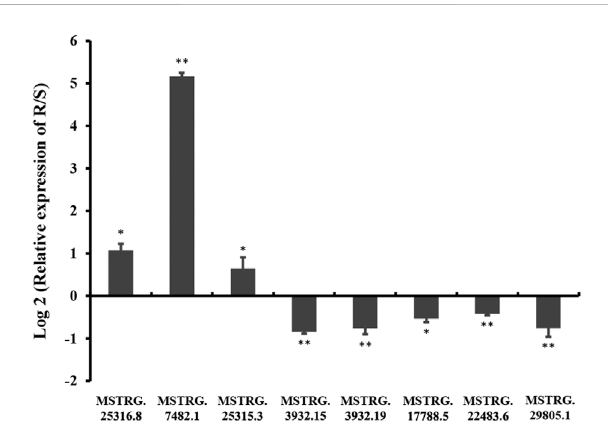
FIGURE 7 Relative expression levels of lincRNAs in chlorantraniliprole- resistant strains(R)and susceptiblestrains (S).Thecolumnrepresentsthe value of log2 (relative expression levels of lincRNAs in the R strain compared to the S strain). Each column represents the mean of three to four biological samples. Error bars represent the standard deviation from the mean. The change in the expression level was calculated using the 2 − ΔΔ Ct method. Data were normalized to the expression of housekeeping genes (Actin A1). Asterisks on the error bars show signi fi cant differences ( p < 05 or p < 01).